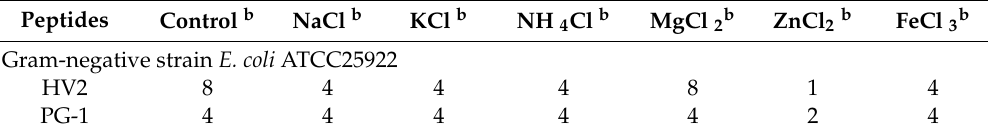
Table 3. MIC values of peptides in the presence of physiological salts. a